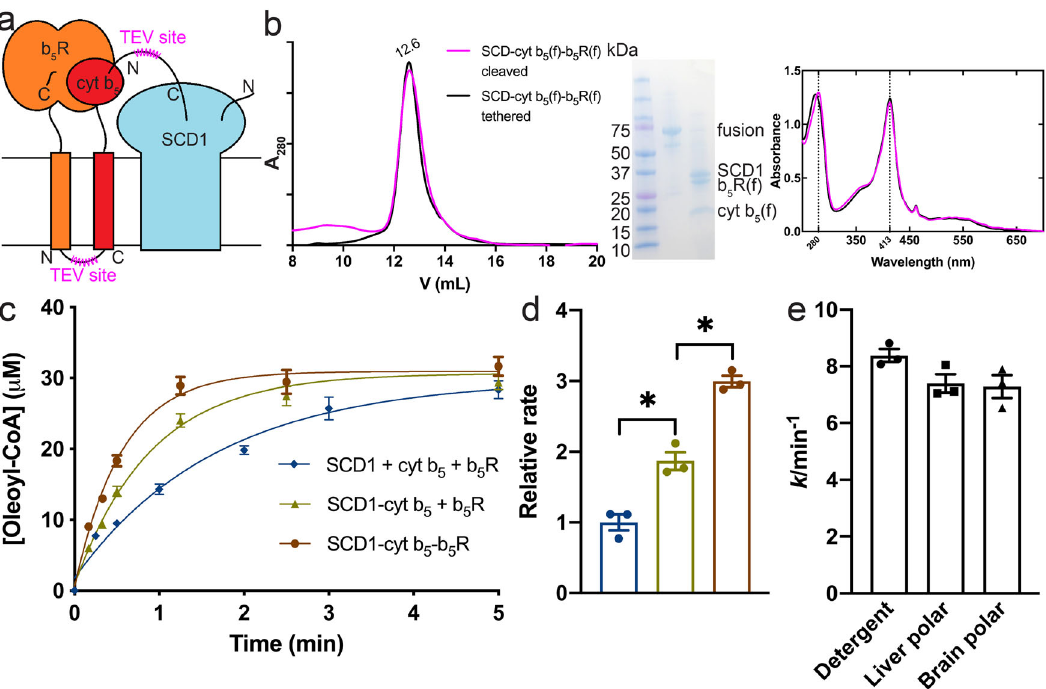
Fig. 5 SCD1, full-length cyt b5, and full-length b5R can form a stable complex with faster electron transfer kinetics. a Schematic diagram of SCD1-cyt b 5 fusion constructs. b SEC pro fi le (left), SDS-PAGE image (inset), and UV-Vis spectra (right) of the linker-cleaved (magenta) and tethered (black) fusion of SCD1-cyt b 5 -b 5 R. Almost identical SEC pro fi le and optical spectra suggest the stable assembly among SCD1, cyt b 5 , and b 5 R. c Time courses of oleoyl-CoA production ( n = 3) in: individual SCD1, cyt b 5 and b 5 R (blue); the binary complex of SCD1-cyt b 5 and individual b 5 R (yellow); the ternary complex of SCD1- cyt b 5 -b 5 R (brown). d Initial rate comparison among conditions in c ( n = 3). Asterisks indicate signi fi cant different ( p < 0.05) in pairwise t tests. e Initial rates of the SCD1-cyt b 5 -b 5 R complex in detergent or liposomes. Error bars represent SEM from three independent repeats ( n =